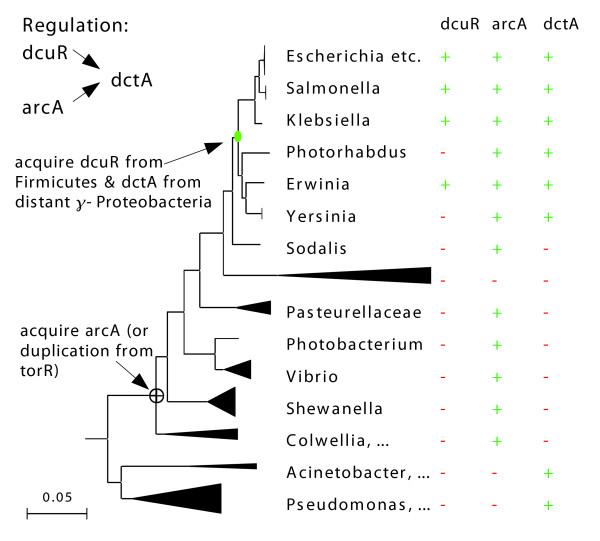
Convergent evolution of regulation of dctA by two distantly-related response regulators. From the gene trees (not shown), we identified subfamilies that correspond to dctA, dcuR, and arcA. For example, we split arcA and its relatives from the closely related torR subfamily of response regulators, which is also present in many γ-Proteobacteria. We show the presence and absence of these subfamilies within the γ-Proteobacteria. The coexistence of dcuR and dctA in the genome is relatively recent, which shows that this regulation evolved after dcuR diverged from arcA.